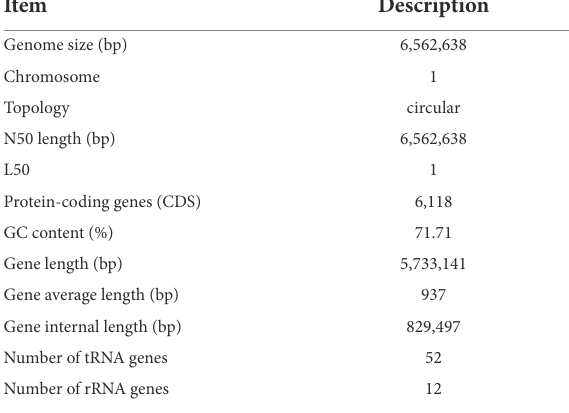
TABLE 2 General feature of the genome of S. rosea